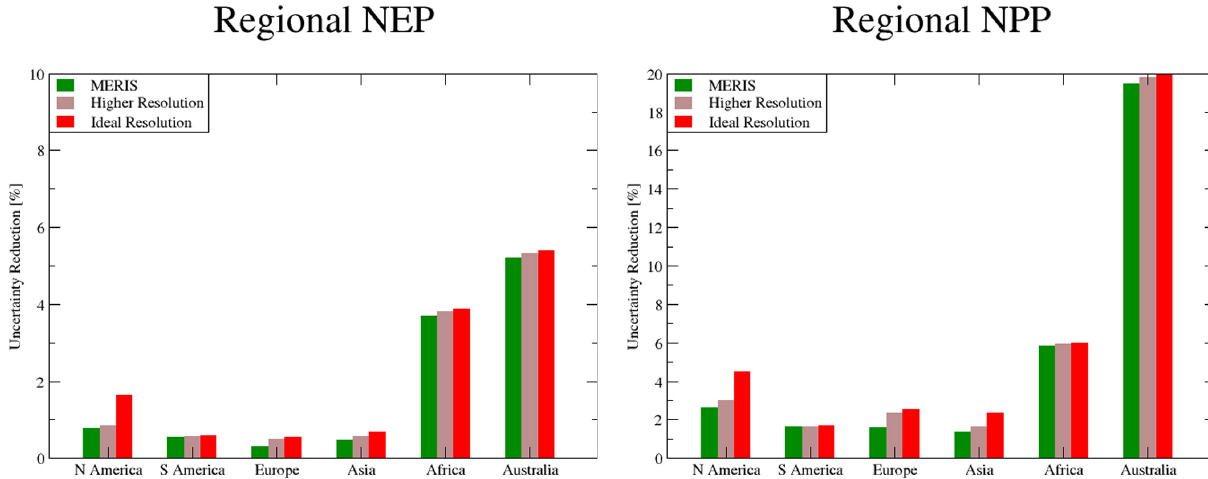
Fig. 10. Reduction in uncertainty in NEP (left hand panel) and NPP (right hand panel) over six regions from three sensor concepts: the MERIS sensor (green), the higher resolution sensor (brown), and the ideal resolution sensor (red).